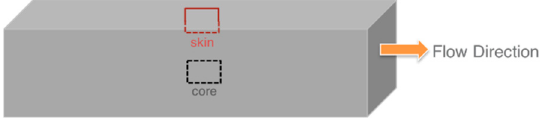
Figure 3. Illustration of injection-molded specimen with marked cutting positions for TEM